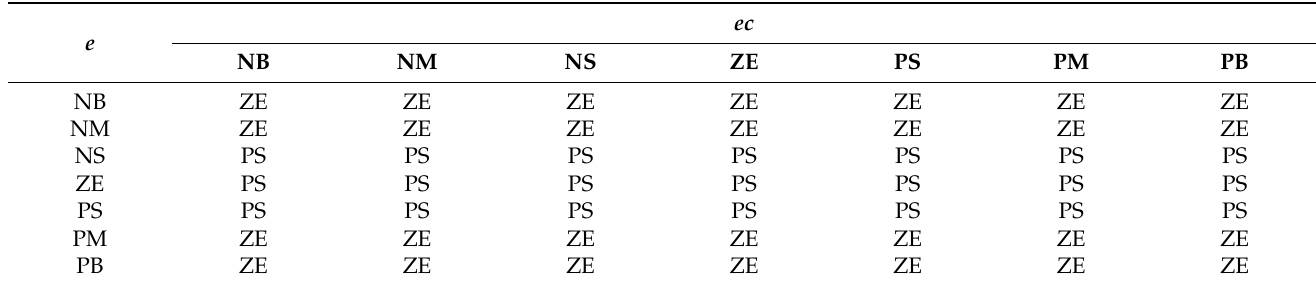
Table 9. Setting rules of ∆ K D .